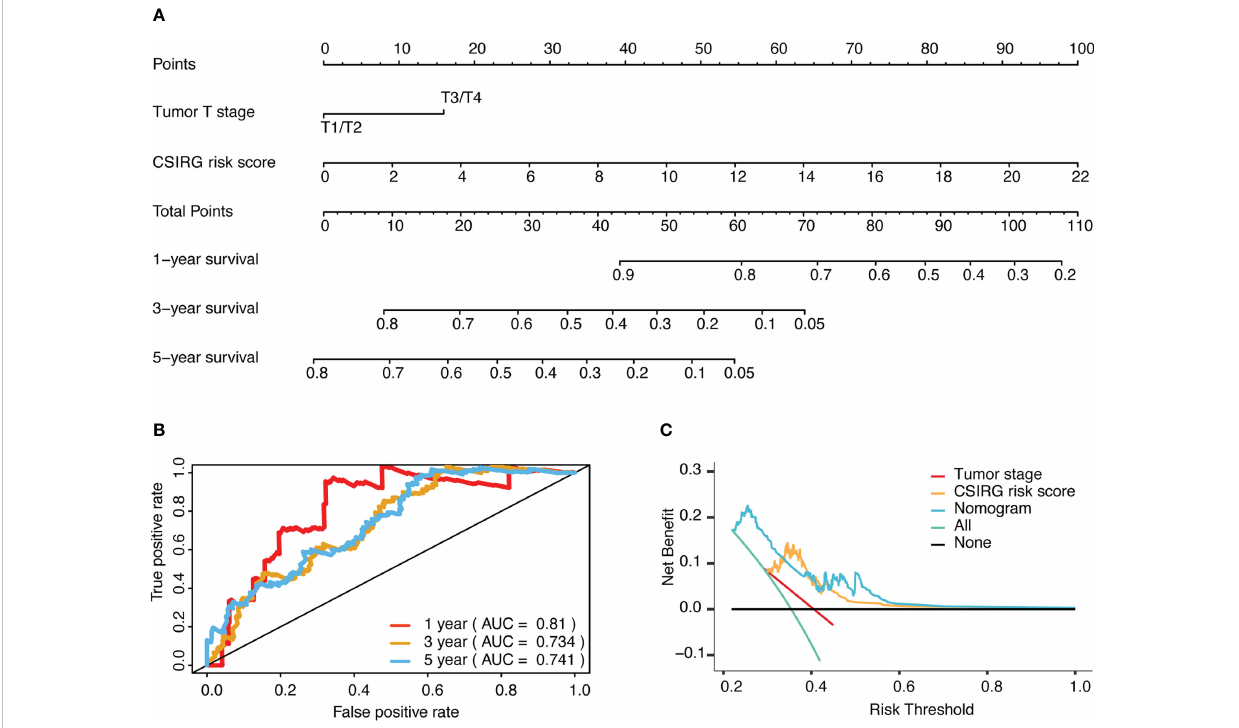
FIGURE 5 Development and evaluation of a risk-based predictive nomogram for melanoma. (A) A nomogram for predicting melanoma prognosis that includes the CSIRG RS and tumor T stage. (B) Receiver operating characteristic curves and the area under the receiver operating characteristic curve evaluation of the nomogram performance of 1-, 3-, and 5-year OS. (C) Decision curve evaluation of the nomogram performance for 5-year